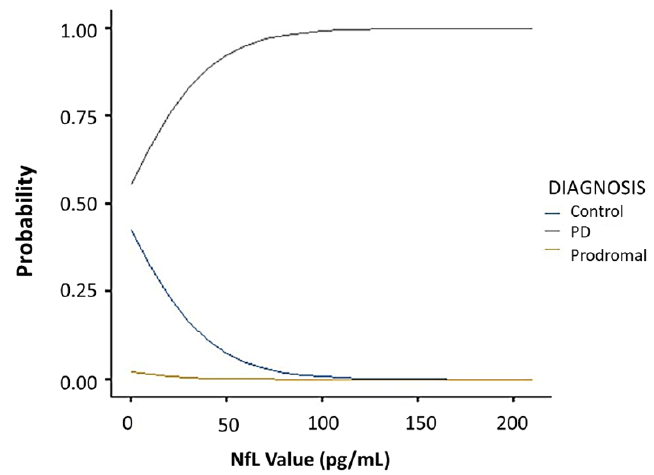
Figure 4. Multinominal logistic regression curves showing the correlation between blood NfL value and the probability of being classed into the control, PD, or prodromal group in pooled PPMI and SHH cohorts. SHH, Shuang Ho Hospital; PPMI, Parkinson’s Progression Markers Initiative.